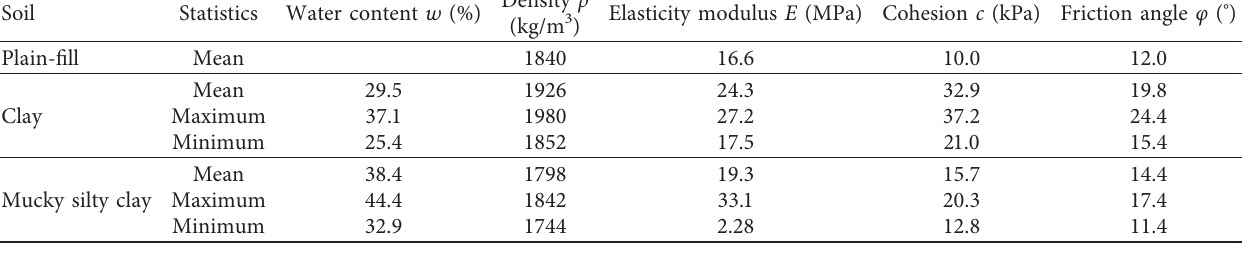
Table 1: Physical and mechanical parameters of soil layers.